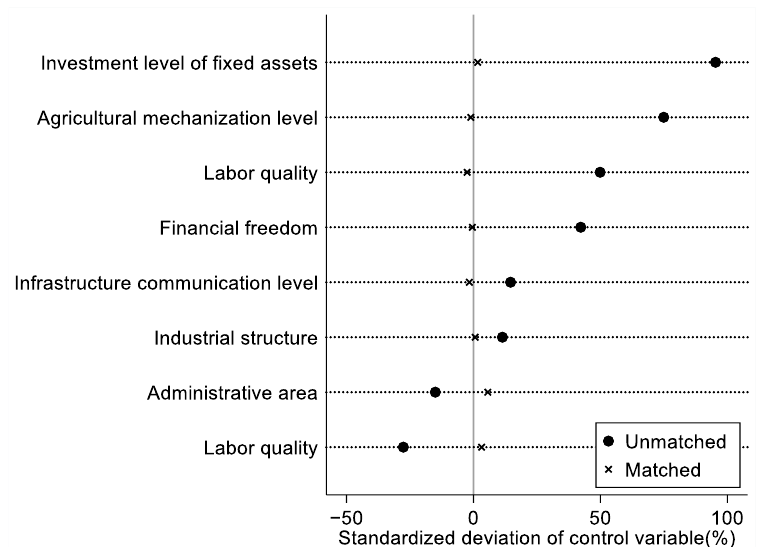
Figure 5. Balance inspection chart.